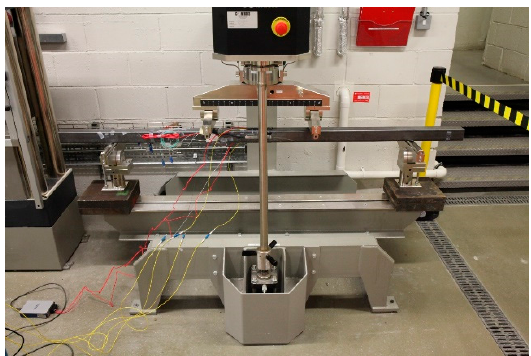
Figure 9. Test rig used in this work for assessment of the packaged sensors developed.